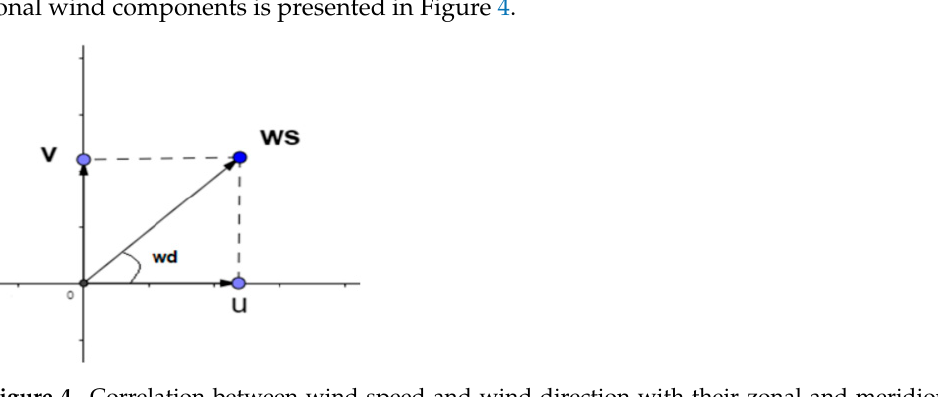
Figure 4. Correlation between wind speed and wind direction with their zonal and meridional components.